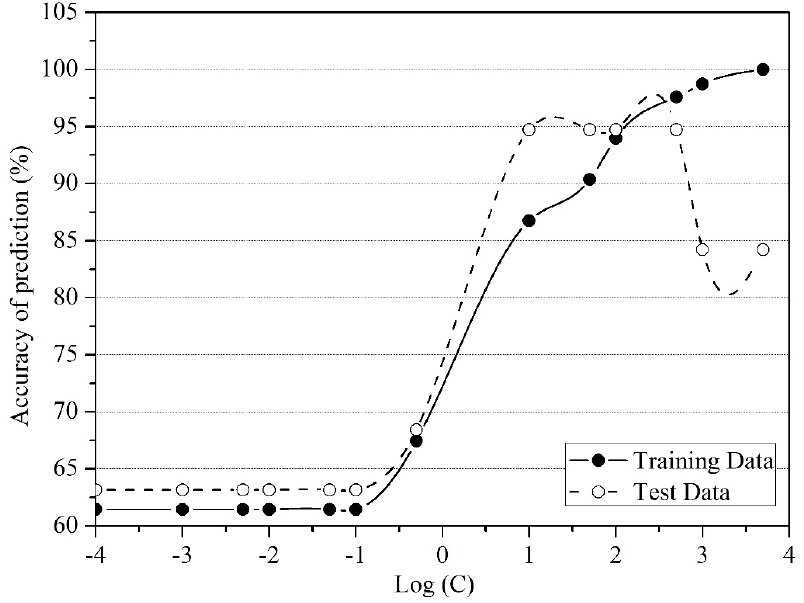
Figure 7. Dependence of the accuracy of classification on the cost parameter C.